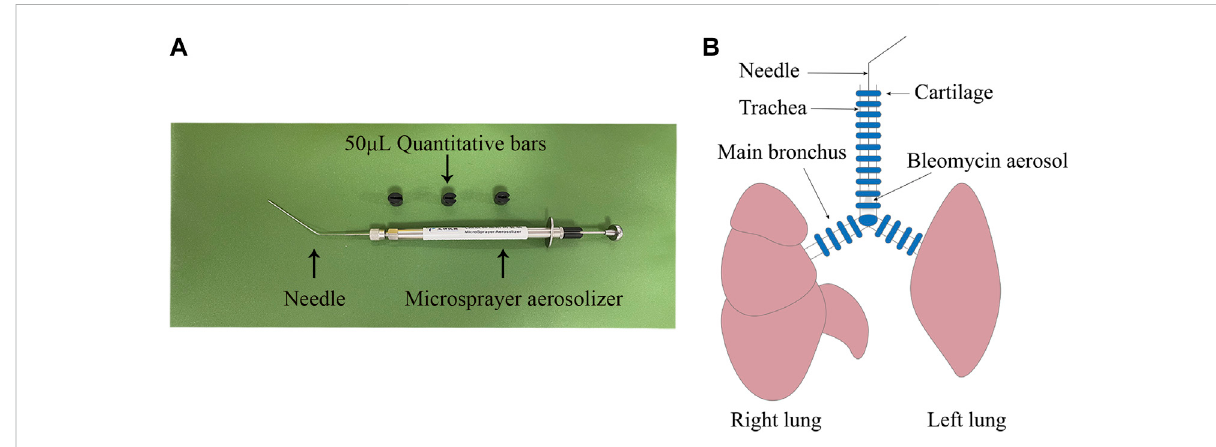
FIGURE 1 Establishment of pulmonary fi brosis model. (A) A microsprayer aerosolizer was used to deliver aerosols of PBS or bleomycin into the lungs of rats (B) The aerosols were presented in the lower